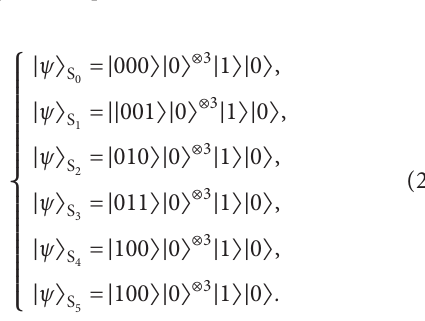
Figure 6: Quantum circuit of finding k nearest neighbor